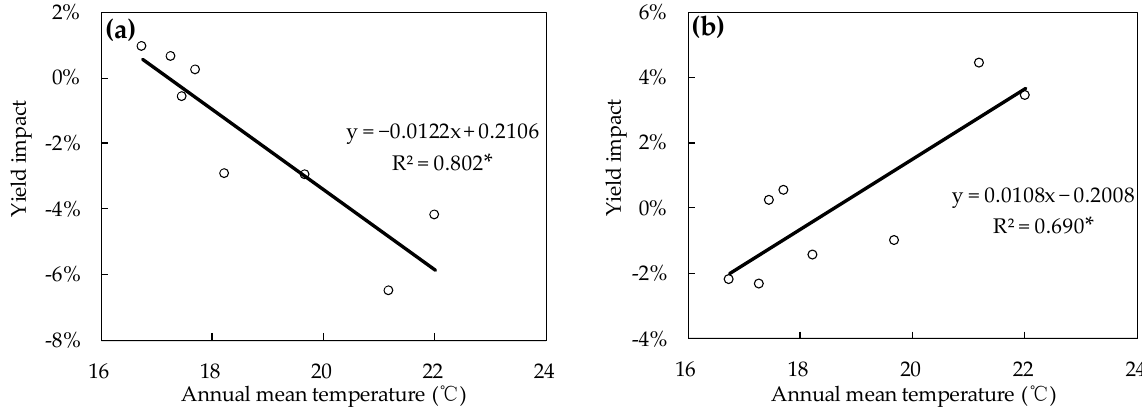
Figure 8. Relationship between annual average temperature and double rice yield change rate. ( a ) early rice; ( b ) late rice. * Significant at p < 0.05.